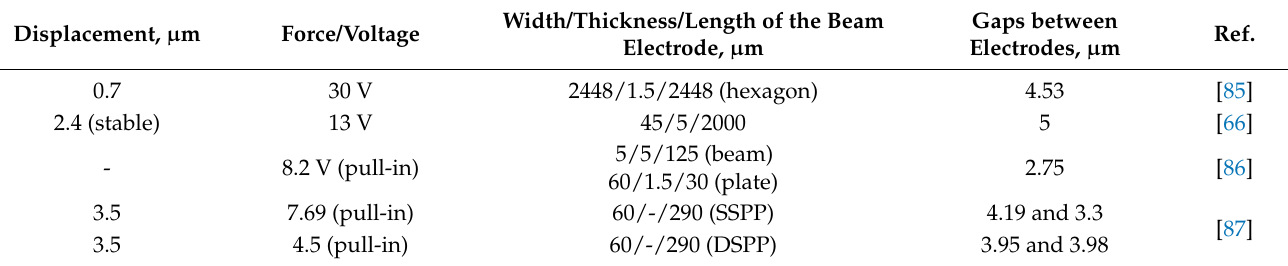
Table 4. Design of parallel-plate actuators reported in last 5 years.